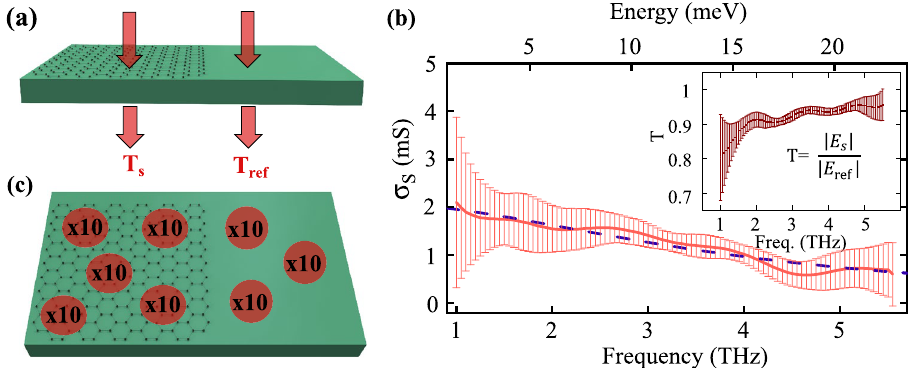
Figure 2. Description of the THz spectroscopy experimental procedure. ( a ) Geometry of the THz reference and sample measurement. ( b ) The real sheet conductivity is extracted by comparing the transmission through the reference and sample (inset). Solid line represents experimental data and the error; dashed line represents the error weighted Drude fit to the data. This data is obtained for graphene on the Si 3 N 4 substrate. ( c ) Description of the data collected for signal averaging and estimation of uncertainty: 10 scans are taken at a single spot on the graphene sample, indicated by a red dot. This is repeated across the sample at different spots at least 5 times, indicated by the several red